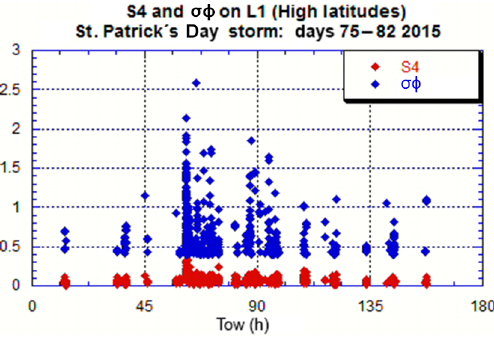
Figure 17. High-latitude scintillation recorded in Sodankylä (Fin- land).